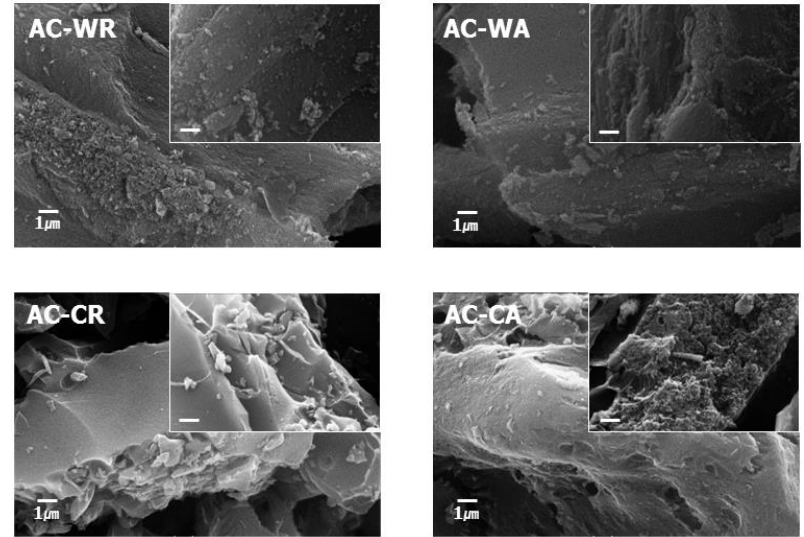
Figure 2. SEM image of altered carbon (AC) such as AC-WR, AC-WA, AC-CR, and